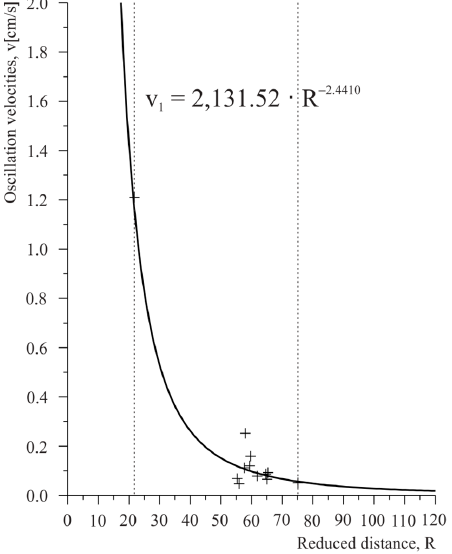
Figure 6. Graphic survey of soil oscillation law curve in the Kovilova č a Open Pit